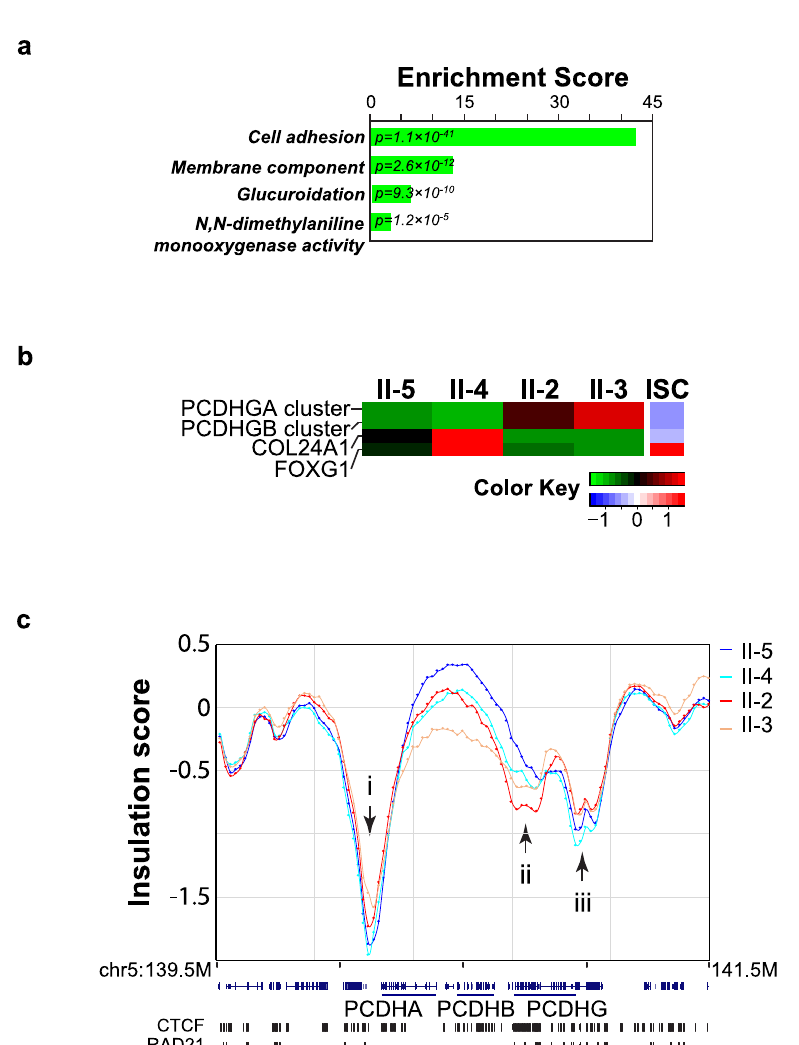
Figure 2. Local chromosome organization changes were detected in LCLs. ( a ) The coding genes overlapping with insulation score change (ISC) bins were chosen for functional enrichment analysis. Significant functional groups (FDR < 0.05) identified were cell adhesion, membrane components, glucuronidation, and N , N -dimethylaniline monooxygenase activity. ( b ) Local chromosome structural changes and gene expression changes in LCLs. Four differentially expressed genes/gene clusters showed changes in isolation scores, indicating local chromosome structural alterations may lead to expression changes in LCLs. ( c ) RAD21 R450C caused insulation score changes in PCDH gene clusters. Insulation score profile across the PCDH gene clusters. Both of these loci showed CTCF and RAD21 binding signals (indicated by red arrowheads) in GM12878